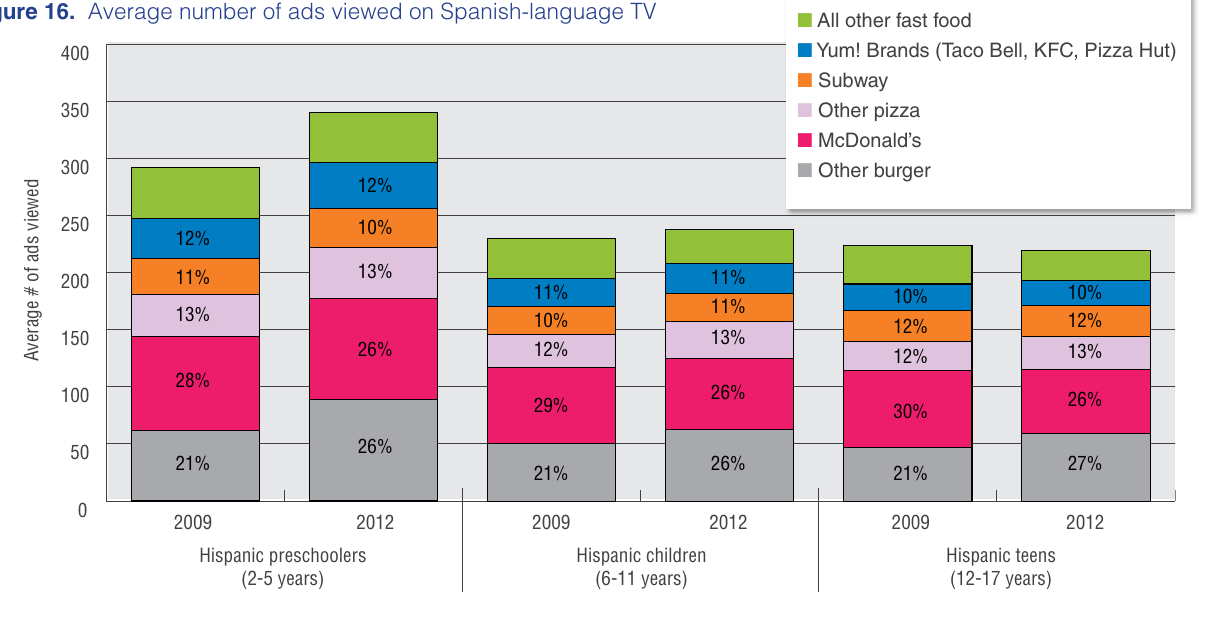
Source: Nielsen (2009,